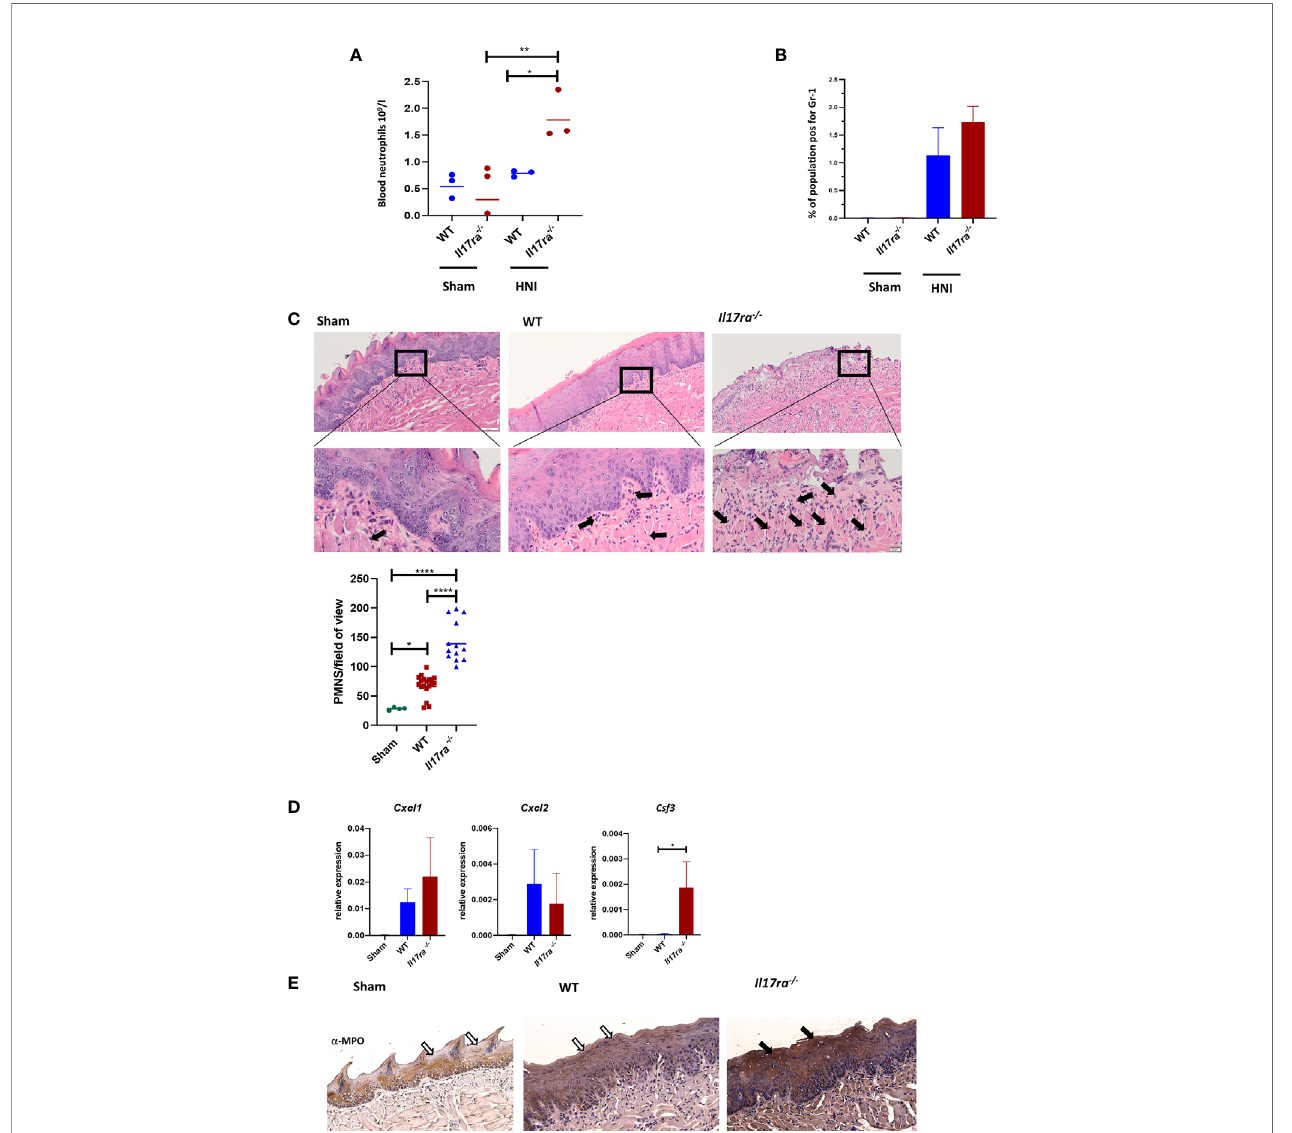
FIGURE 4 | Neutrophil recruitment to the tongue tissue is heightened in the absence of IL-17RA. (A) Cardiac puncture was performed to harvest blood from non- irradiated and irradiated mice and number of circulating neutrophils measured on D11. Data is representative of two independent experiments and analyzed by ANOVA with Tukey ’ s. (B) Tongues harvested on day 11 and neutrophil (Gr1+) populations analyzed by fl ow cytometric analysis and ANOVA with Tukey ’ s. Data representative of two independent experiments (C) Staining by hematoxylin and eosin of sectioned tongues and quanti fi cation of neutrophils on day 11 following HNI. Arrows represent positive neutrophil staining in distal tongue at ulcer boundary (N = at least three tongues per group). Scale bar 100 µM (top row) and 20 µM (bottom row). Neutrophil quanti fi cation analyzed by ANOVA with Tukey ’ s post hoc . (D) Expression of neutrophil chemokines relative to GAPDH on D11 (N = 3 – 5 per group). Cxcl1 analyzed by ANOVA with Tukey ’ s post hoc , Cxcl2 and Csf3 analyzed by Kruskal – Wallace and Dunn ’ s multiple comparisons. Data pooled from at least three experiments. (E) Representative MPO-staining of ulcer boundary counterstained with hematoxylin. The fi lled arrow indicates positive MPO staining, while the un fi lled arrows show the equivalent areas with absent MPO. Scale bar,100 µM. Data shown as means ± SEM, (*P <0.05, **P <0.01,****P